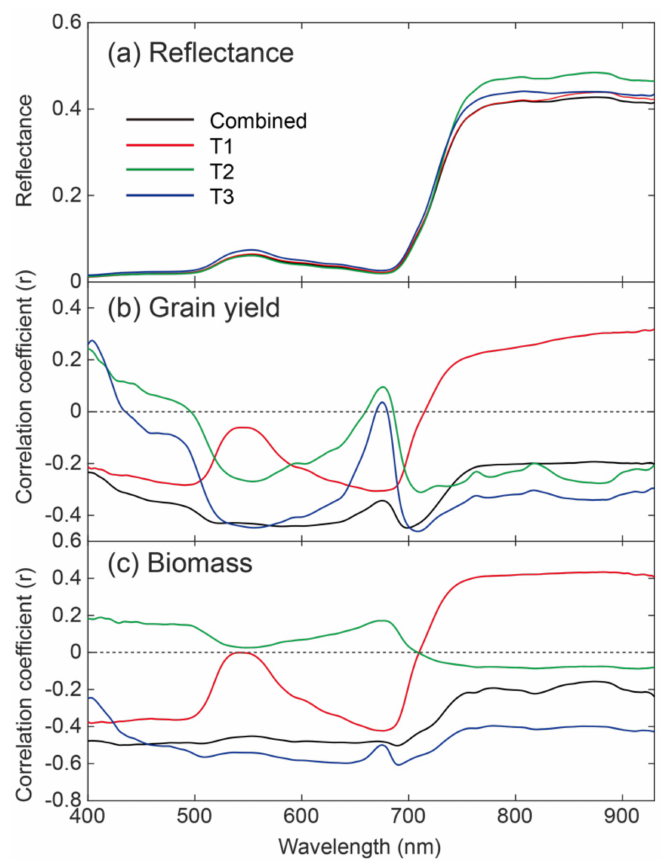
Figure 5. Mean canopy reflectance ( a ) and correlation coefficient ( r ) between the grain yield ( b ), biomass (BM) ( c ) and reflectance at each waveband for the T1, T2, and T3 data